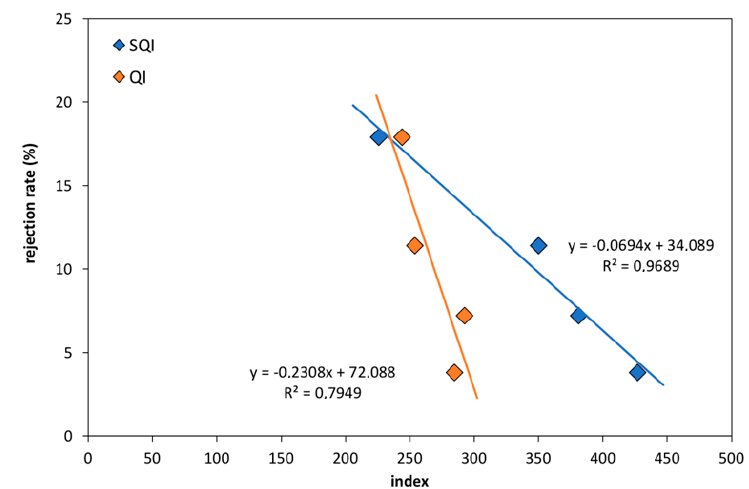
Figure 14. Change of bifilm index with different indices.